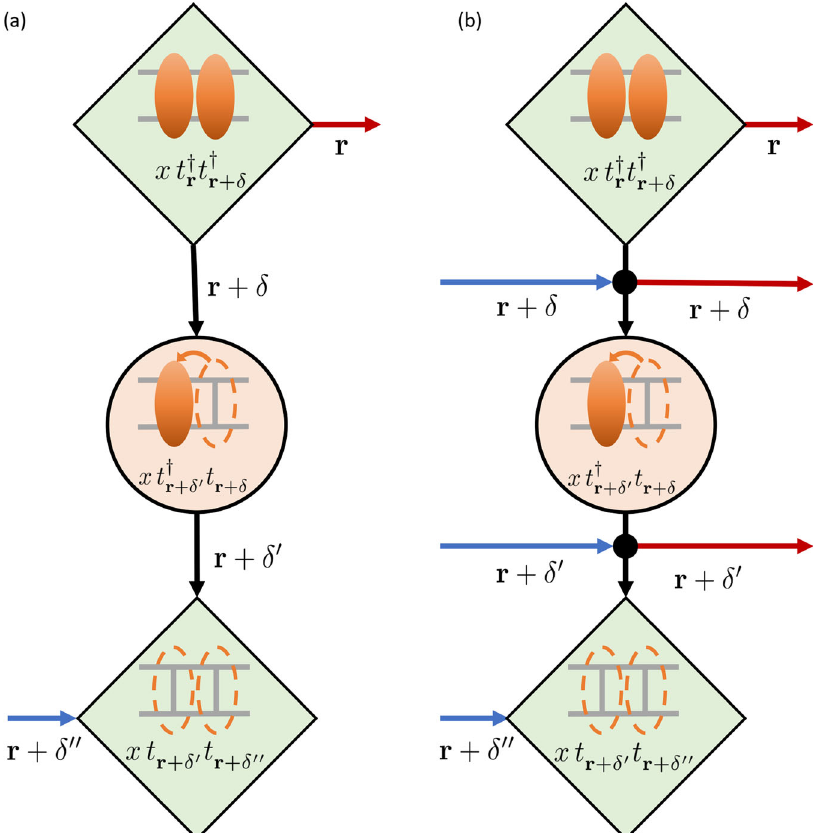
Fig. 2 Origin of three-triplon interactions. The term is depicted in real space at dimer r and interdimer distances δ ; δ 0 ; δ 00 ; note that this term arises in any dimension and for any lattice model with fi nite dimensional local degrees of freedom. Finite x implies hopping, pair creation and annihilation processes during the renormalization by CUT. The blue arrows indicate the incoming triplons, red the scattered triplons and the black arrows internal triplon propagation. For normal bosons ( a ), the combined process is single-particle irreducible and corresponds to an effective hopping. For triplons ( b ), the hard- core constraint (black circles) induces three-triplon interactions in leading order x 3 . The explicit expression for δ ¼ 1 ; δ 0 ¼ 2 ; δ 00 ¼ 3 is given in the Supplementary